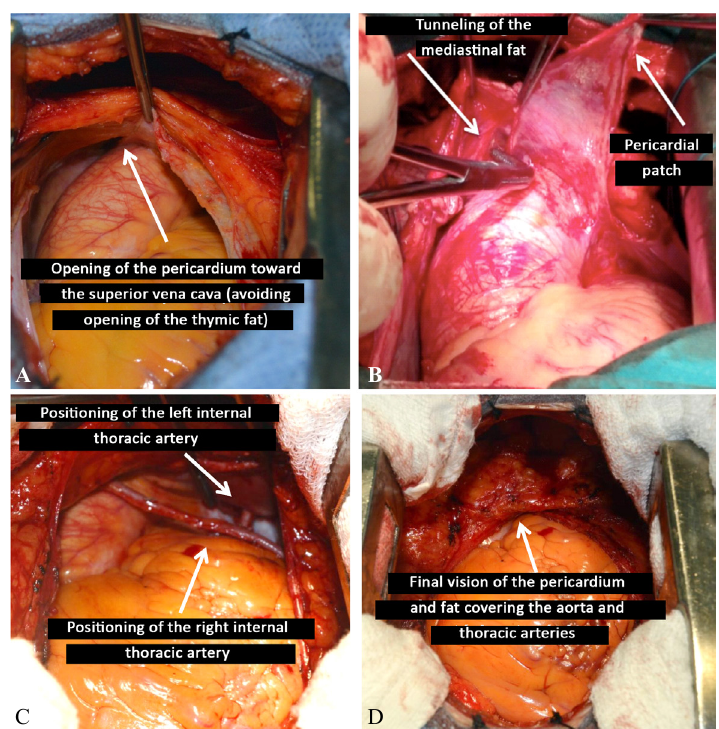
Fig. 2 - (A, B, C and D) Surgical picture showing details of the pericardial patch, tunneling through the mediastinal fat and final vision with the right